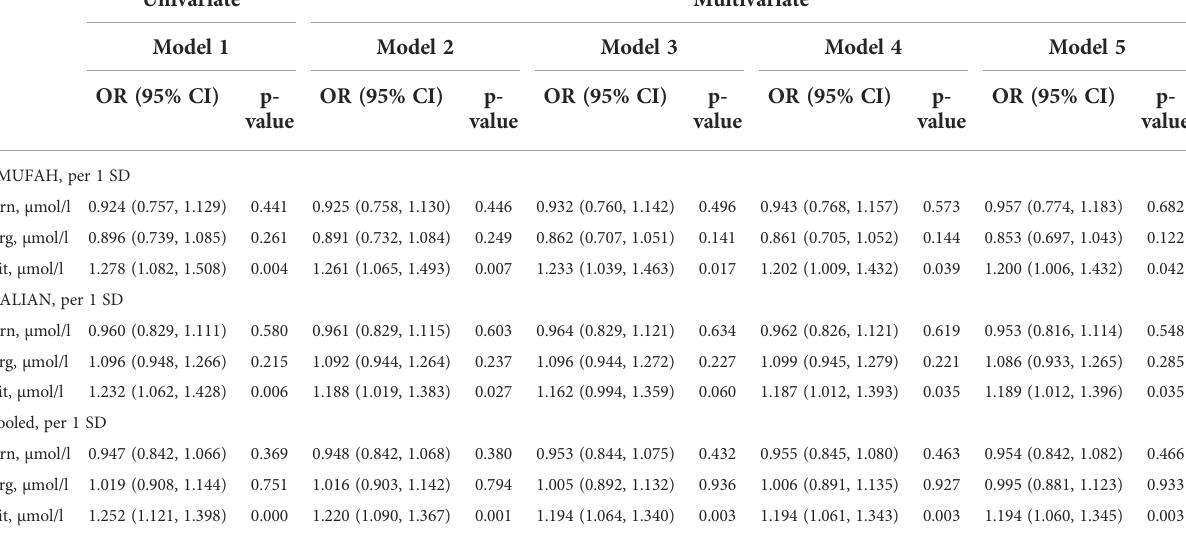
TABLE 2 The difference of amino acids related to the urea cycle by logistic regression in two independent cross-sectional